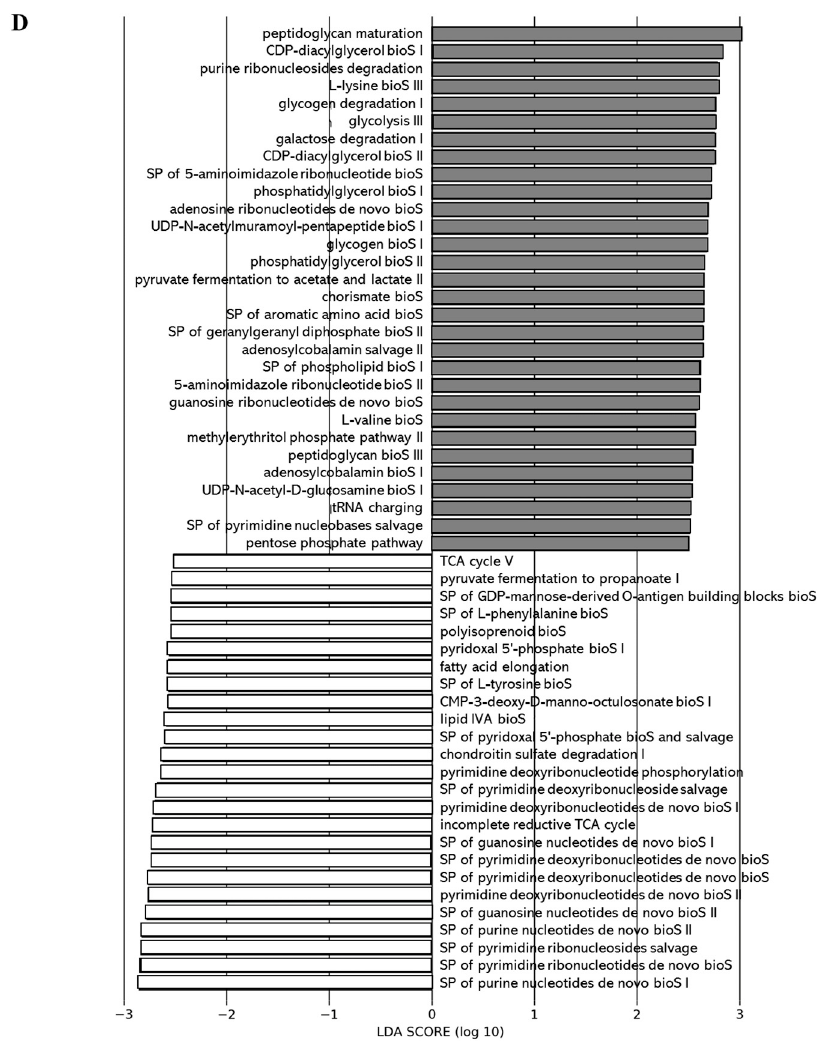
Figure 5. Administration of the different DCJs alter metabolic pathways in the gut microbiota of mice in comparison with the control (water). The linear discriminant analysis (LDA) effect size was calculated in order to explore the microbial functions that more strongly discriminated between the gut microbiota of mice treated with ( A ) water (white) and 0% DCJ (dark), ( B ) water and 40% DCJ (light grey), ( C ) water and 60% DCJ (medium grey), and ( D ) water and 80% DCJ (dark grey). bioS: biosynthesis, SP: superpathway.